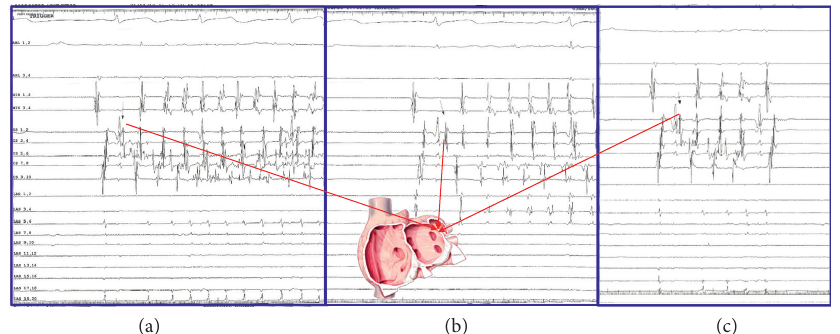
Figure 4: An example of the extrapulmonary trigger. In a patient with long-standing persistent AF, after PVI and the electrical cardioversion to SR, a repeated onset of AF (a, b) is observed with firing from the same point mapped and ablated in the area between left superior PV and LAA (ligament of Marshall). (c) The firing fails to induce AF. Ablation of this area resulted in the long-term SR maintenance for > 18 months.